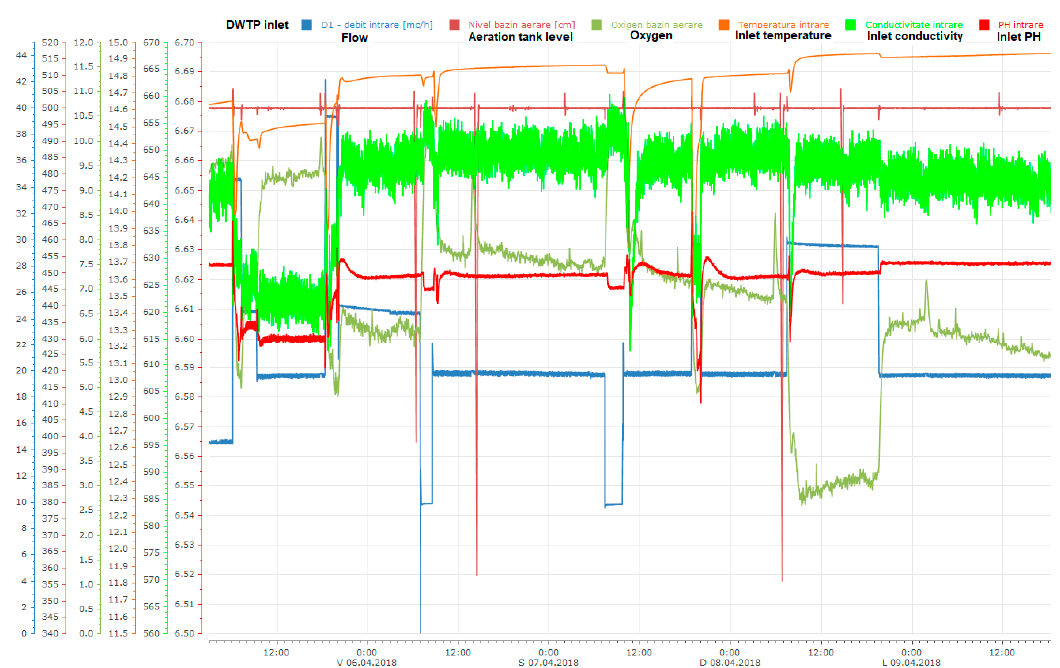
Figure 11. DWTP input parameters.